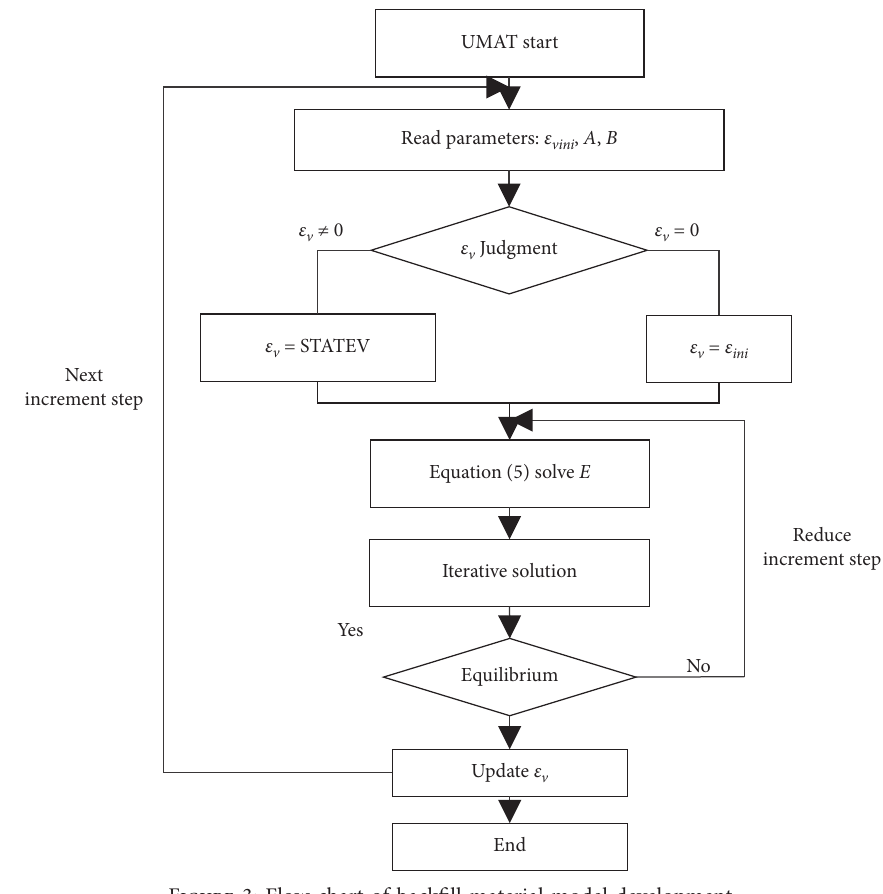
Figure 3: Flow chart of backfill material model